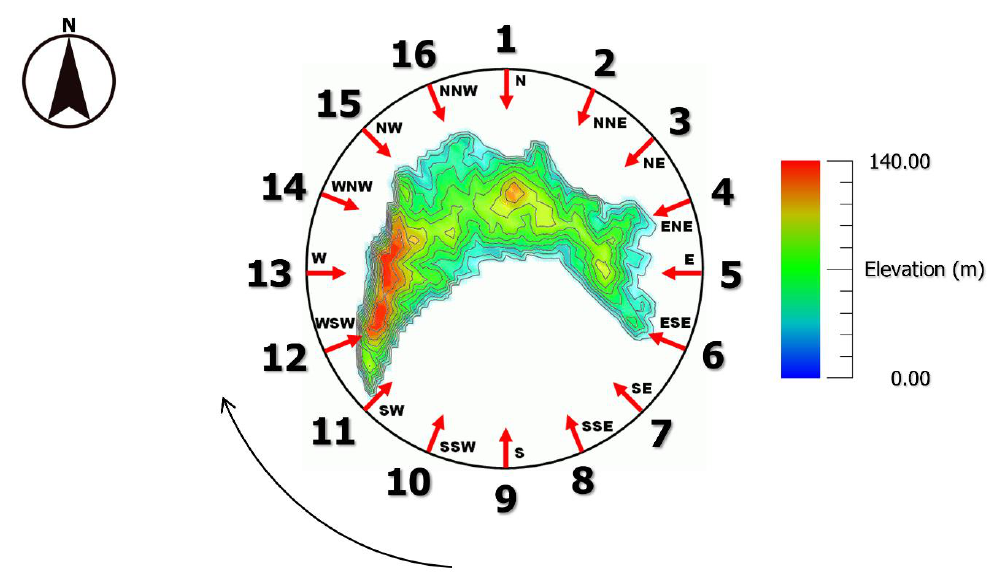
Figure 19. Sixteen wind sectors (each sector is 22.5 degrees).